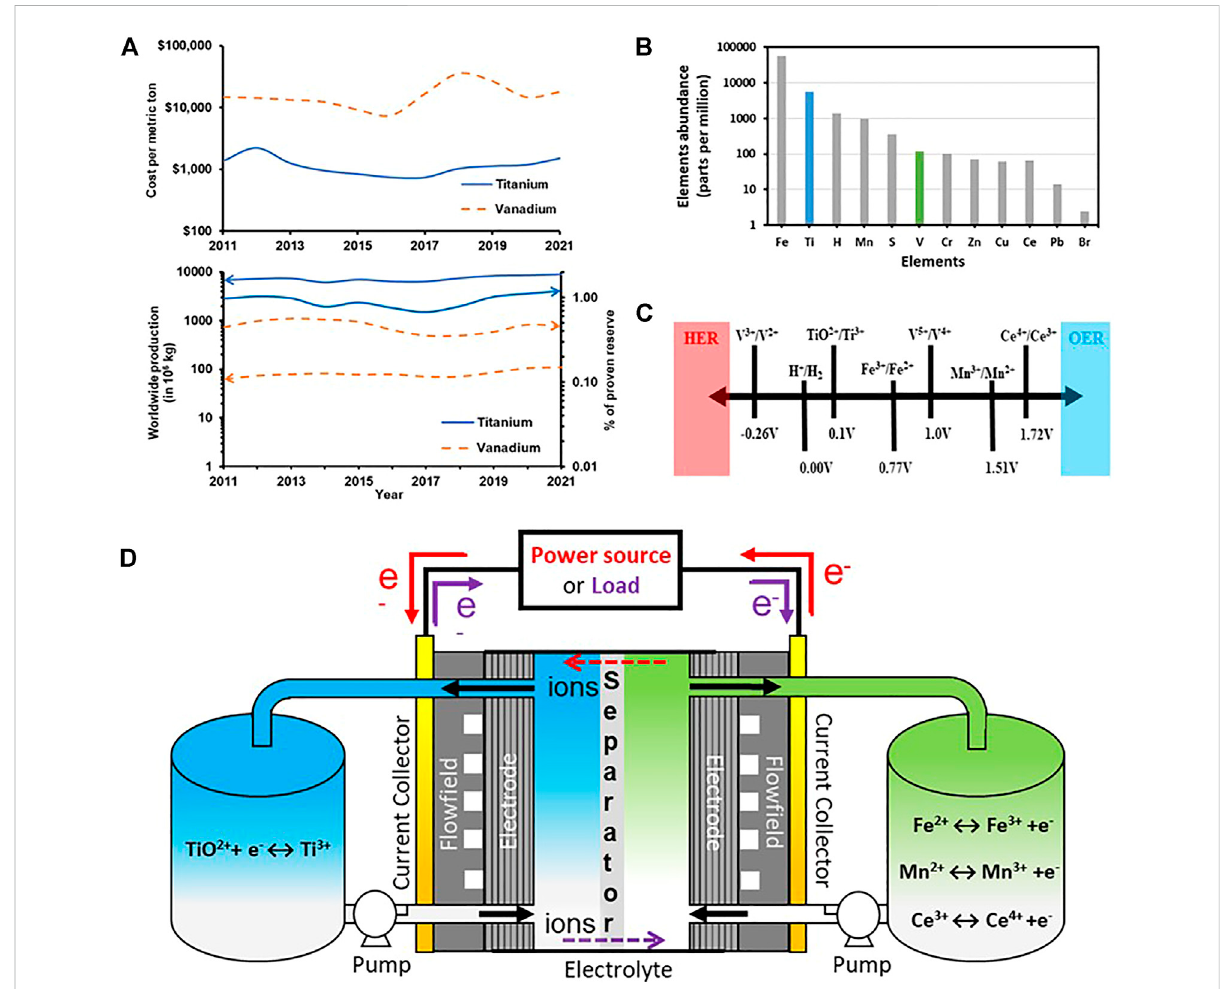
FIGURE 1 (A) Costpermetricton,worldwideproduction,andprovenreservesofTi,andV; (B) AbundanceofTiintheEarthcrust (C) Half-cellpotentials(vs SHE); for some redox couple for possible use in RFBs; (D) Schematic diagram of Ti- X (X = Fe, Mn, Ce)